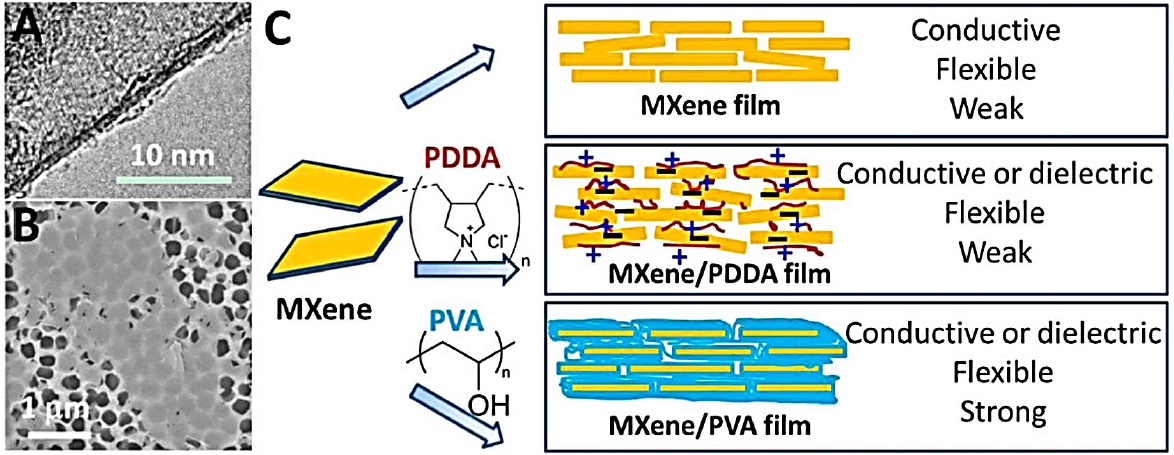
Figure 6. ( A ) TEM and ( B ) SEM images of MXene flakes after delamination and before film formation ( C ) MXene ‐ based functional film schematics [9].